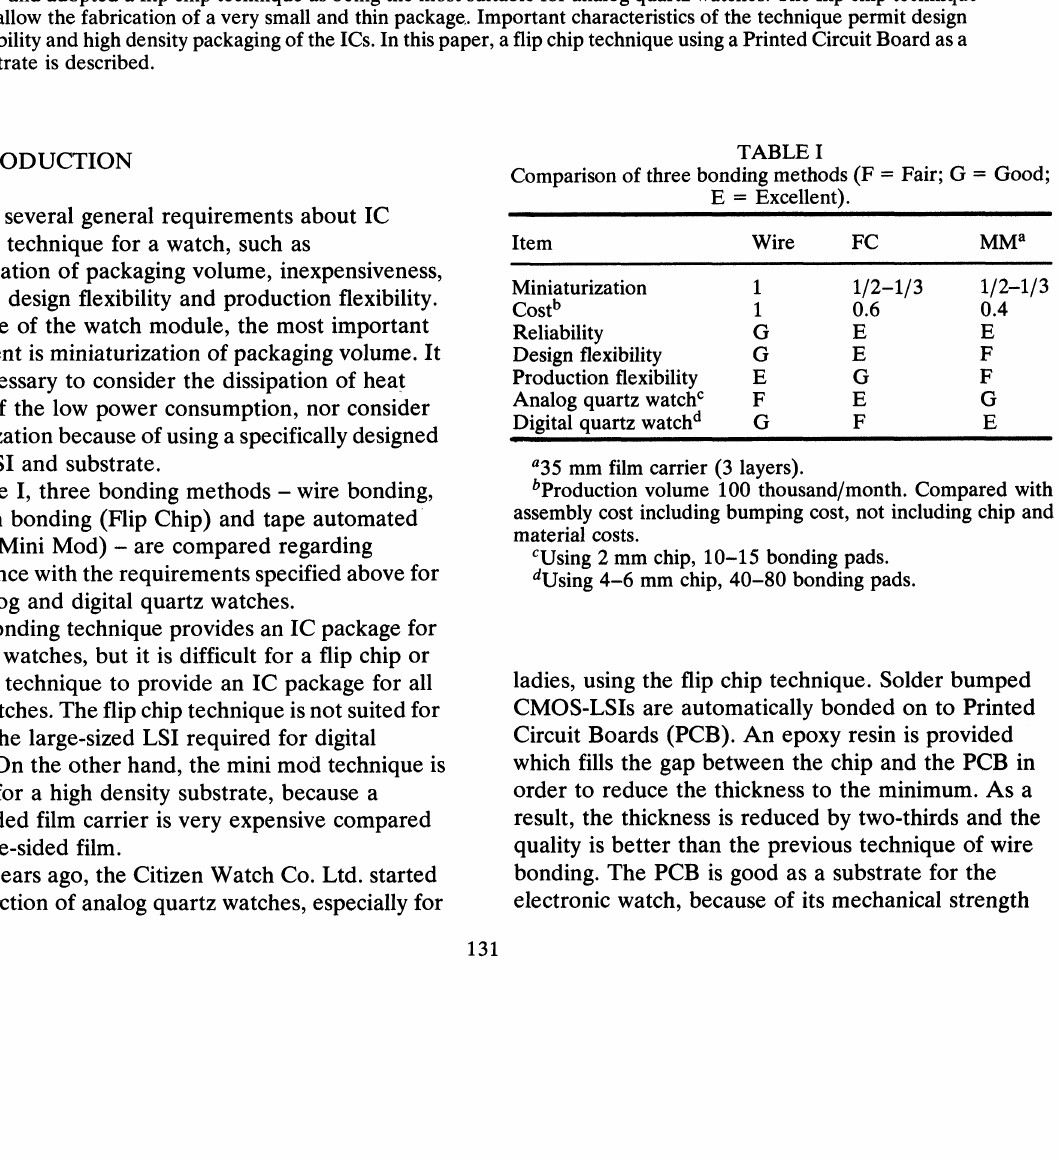
Comparison of three bonding methods (F Fair; G Good;